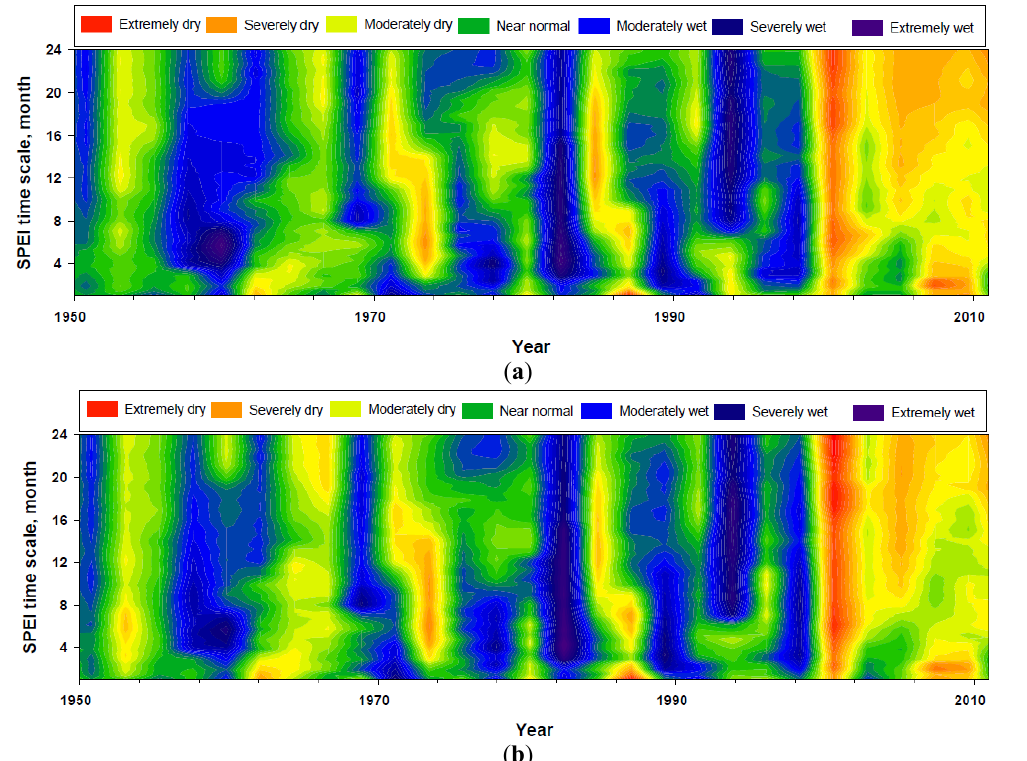
Figure 4. Temporal evolution for the data series of Standardized Precipitation Evapotranspiration Index (SPEI) at time scales from one to 24 months for the period 1950–2010 in ( a ) Buraydah and ( b ) Hail